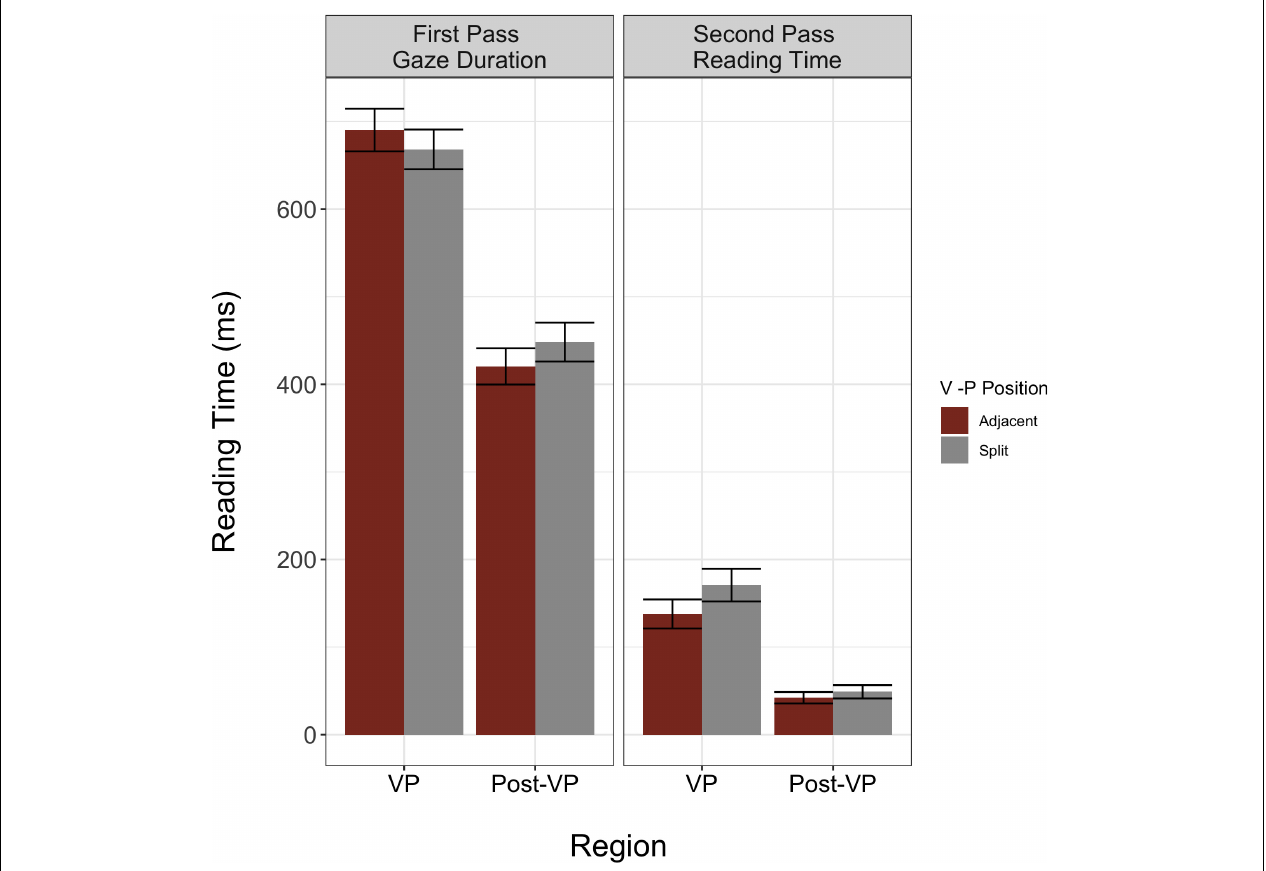
FIGURE 2 | L1 raw reading times for core model (Region × Measure × VP Position). Model indicates a significant interaction between measure and region. Error bars indicate plus/minus one standard error of the